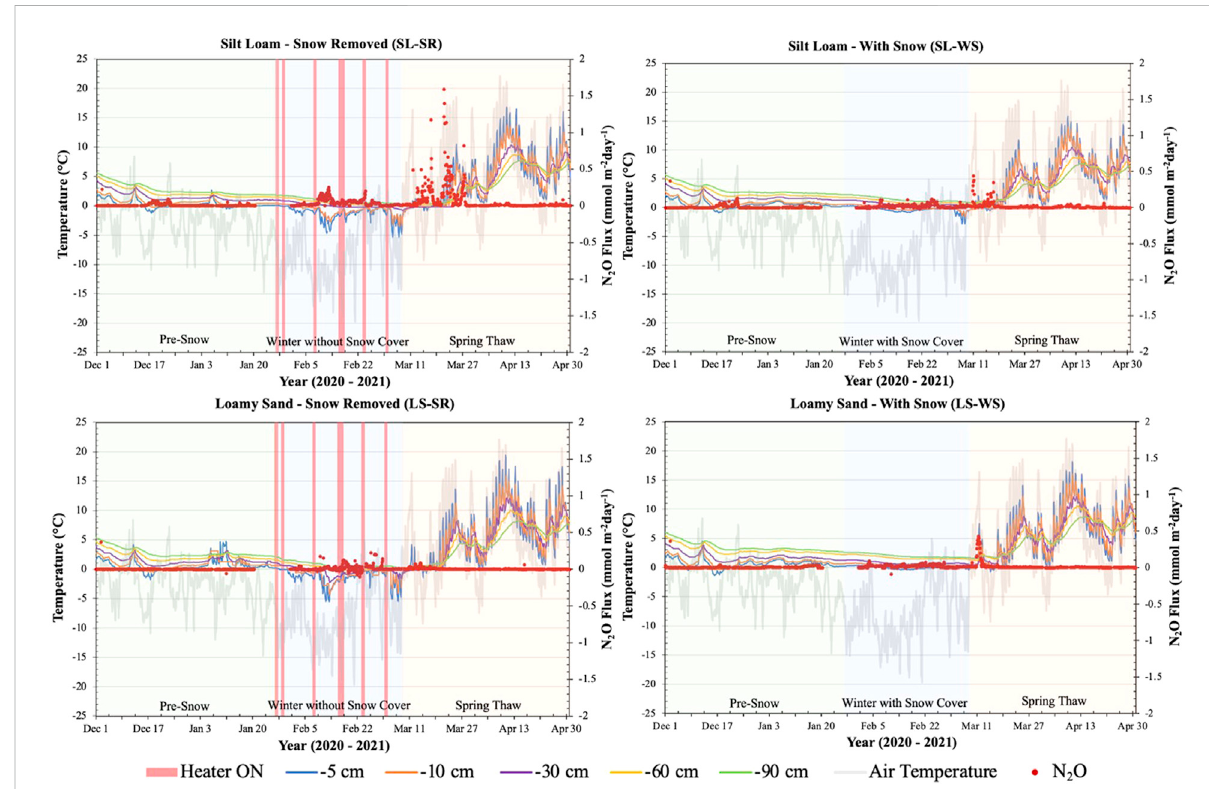
FIGURE 4 Nitrousoxide (N 2 O) fl uxes (secondary y -axis)measuredatthesoilsurfaceinfourlysimetersbetween1December2020, and30April 2021.N 2 O fl uxes are plotted with soil temperature at -5, -10, -30, -60 – 90 cm depths and air temperature recorded from the Environment Canada Elora Weather Station. The graphs SL-SR and LS-SR also show when the heaters were turned on and off during the winter to melt snow on the lysimeter surface (red bars on winter without snow cover phase). The graphs are divided into three phases, pre-snow, winter with/without snow, and spring-thaw, to determine the patterns of change during each of the experimental